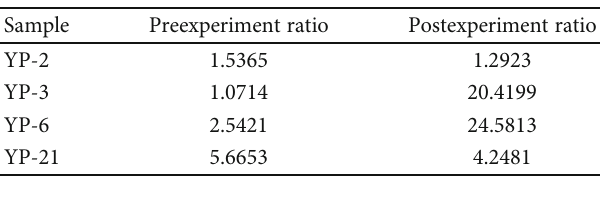
Figure 9: Correlation curves of the hydraulic conductivity and the average pore-throat radius Table 8: The pore-throat ratio before and after the seepage experiments.